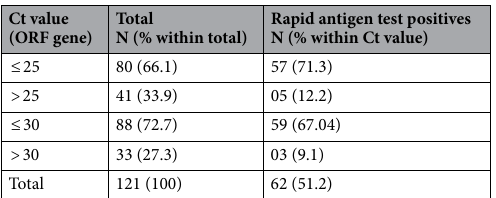
Table 3. Oral swab Rapid Antigen Test results by Cycle threshold (Ct) value cut-offs.